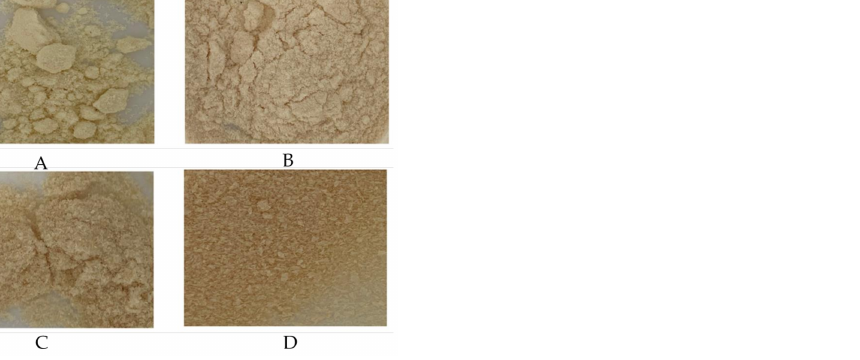
Figure 3. Pictures of the pea water powders. ( A ) Spray-dried pea soaking powder, ( B ) Spray-dried pea cooking powder, ( C ) Freeze-dried pea soaking powder, ( D ) Freeze-dried pea cooking powder.